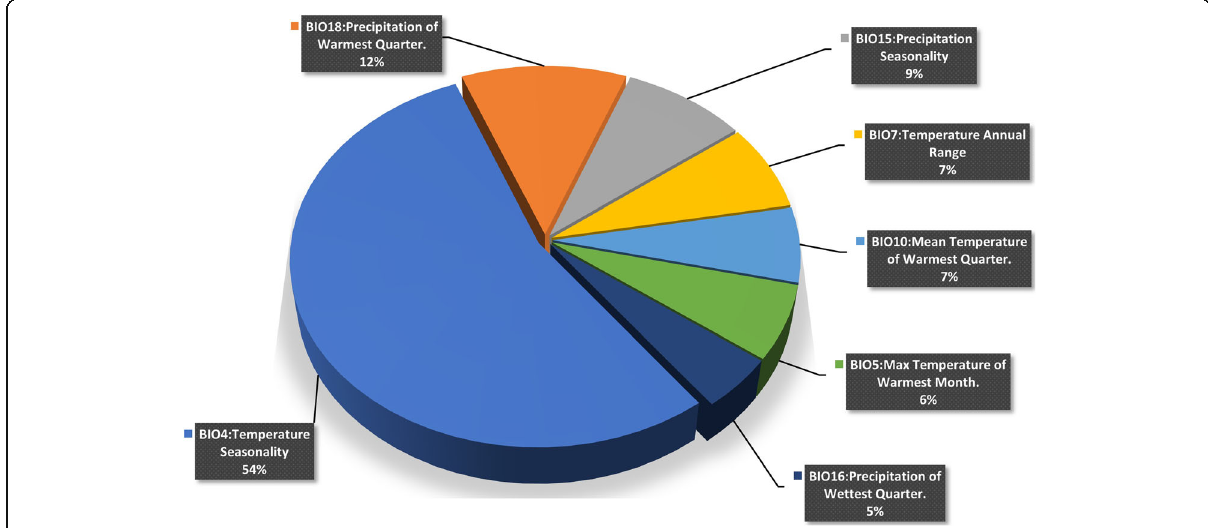
Fig. 11 Analysis of variables contributes to the prediction distribution model of D.